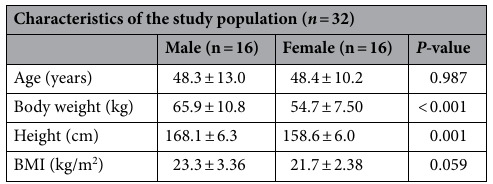
Table 1. Characteristics of the study population. BMI : body mass index.